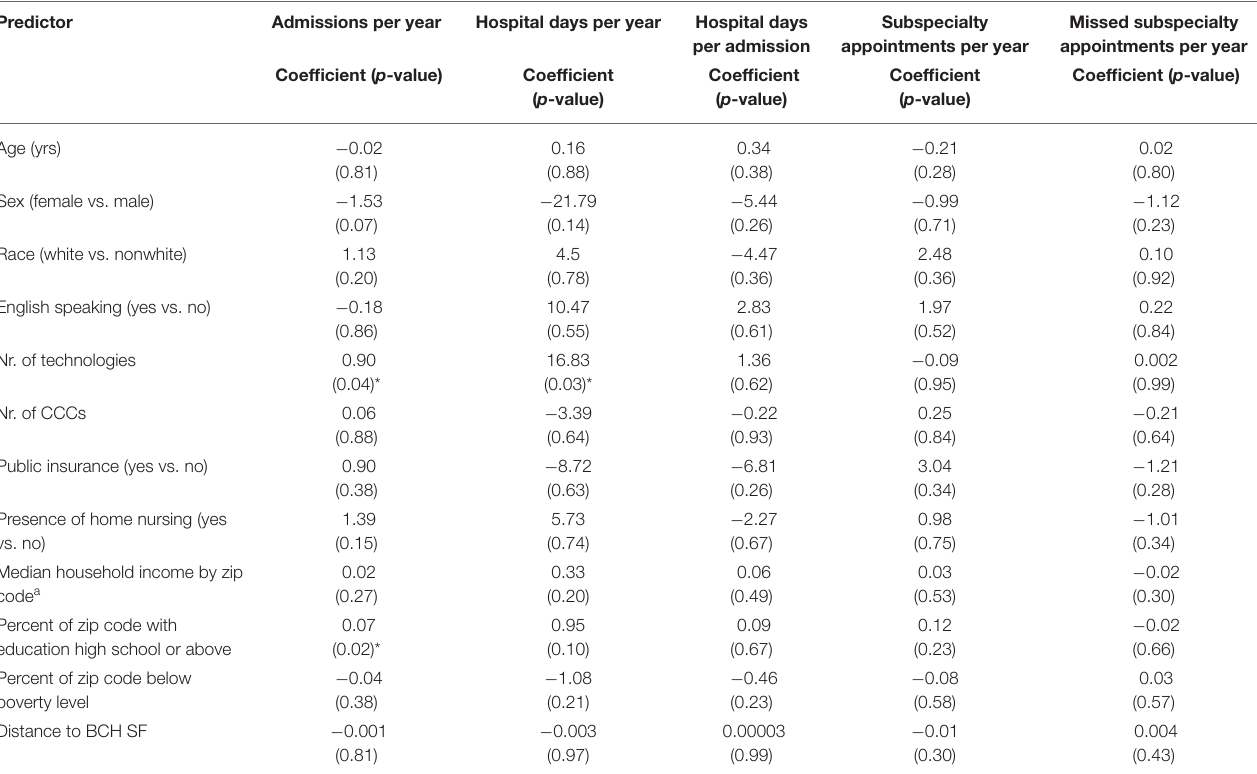
TABLE 4 | Associations between five measures of healthcare utilization in the FLIGHT patient group ( n = 64) and patient characteristics controlling for age, number of technologies, and number of